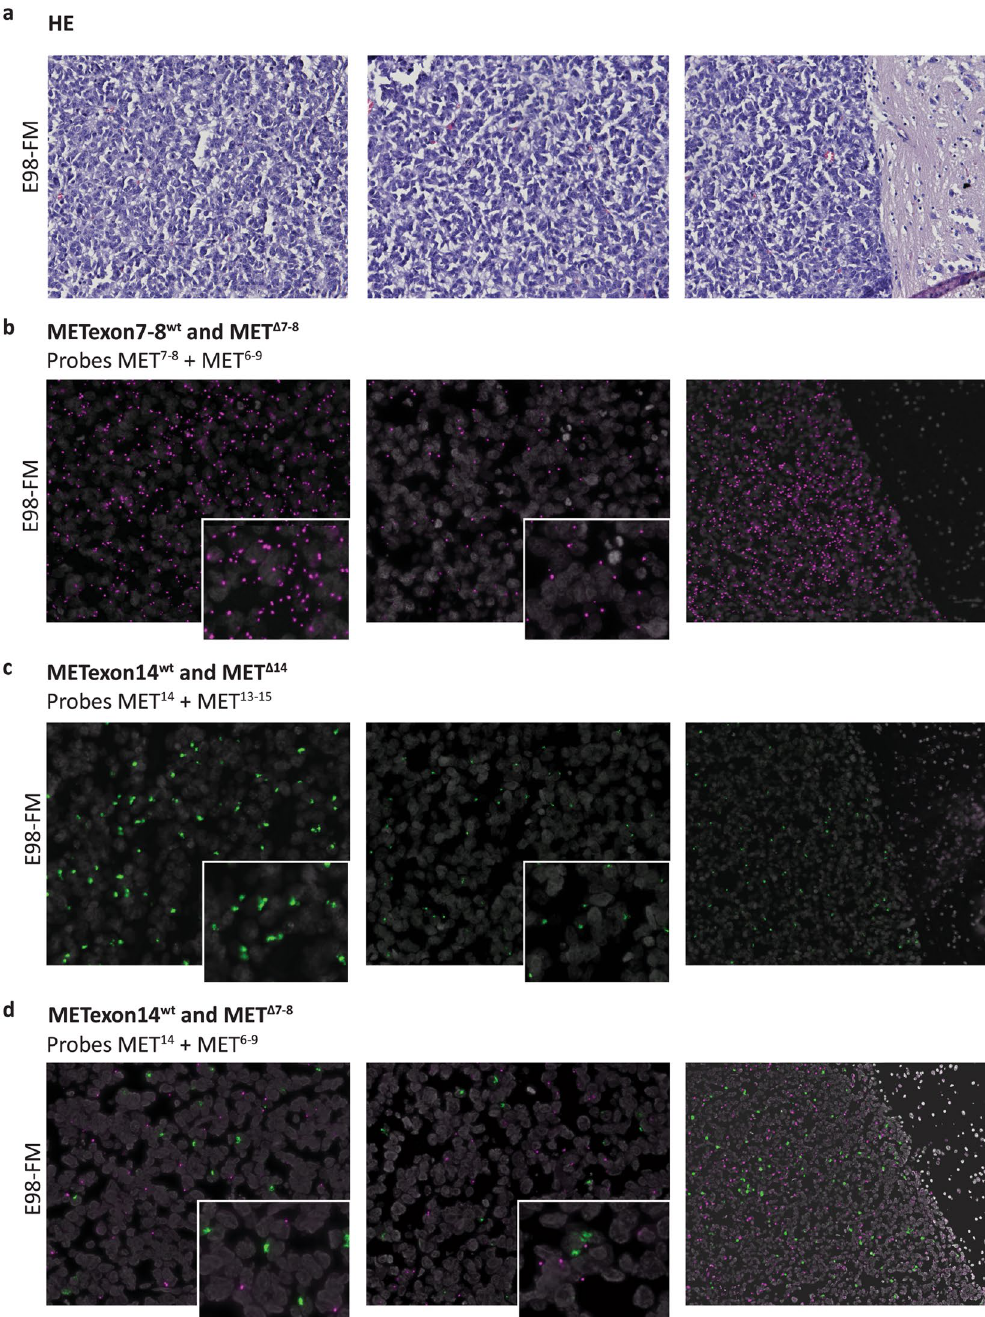
Figure 6. Multi-plex in situ mutation detection of MET using padlock probe rolling circle amplification on E98-FM FFPE xenograft tissue. ( a ) Serial H&E stainings. ( b ) In situ duo-probe detection of METexon7–8 wt and MET Δ 7-8 transcripts using padlock probes MET 7,8 and MET 6–9 , respectively. ( c ) In situ duo-probe detection of METexon14 wt and MET Δ 14 transcripts using padlock probes MET 14 and MET 13–15 , respectively. ( d ) In situ duo-probe detection of METexon14 wt and MET Δ 7-8 transcripts using padlock probes MET 14 and MET 6–9 , respectively. Wild-type transcripts are displayed as green RCPs, mutant transcripts are displayed as magenta RCPs. Cell nuclei are shown in grey. Note that in all assays the tumour border emphasizes the specificity of the padlock probes, showing no fluorescent detection spots in normal brain tissue (right figures, original magnification 20x). Compare the left and middle panels for each assay, visualizing differences in transcript expression in different tumour areas. Inserts give a zoomed view of the underlying image. Original magnification